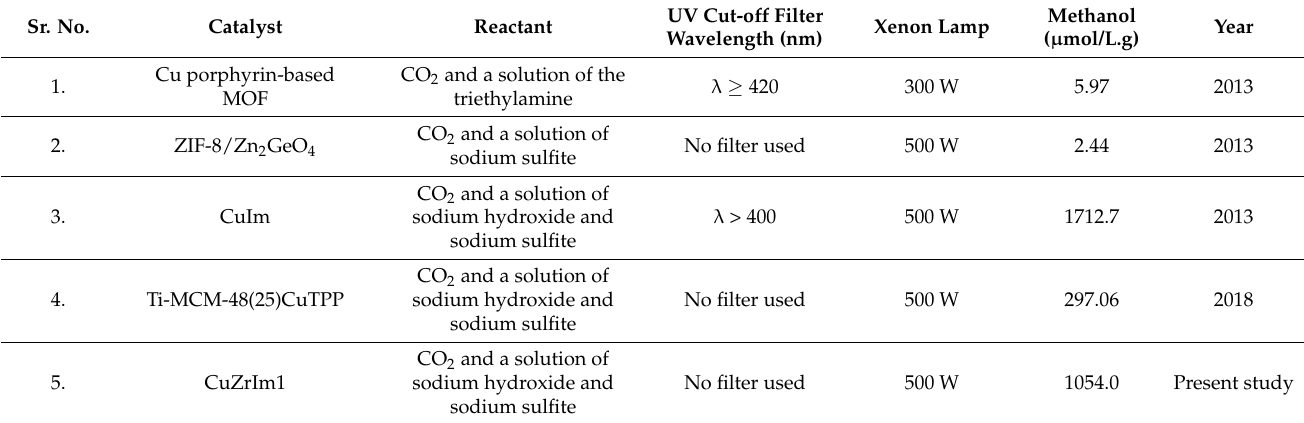
Table 7. Recent progress in photocatalytically reduction of CO 2